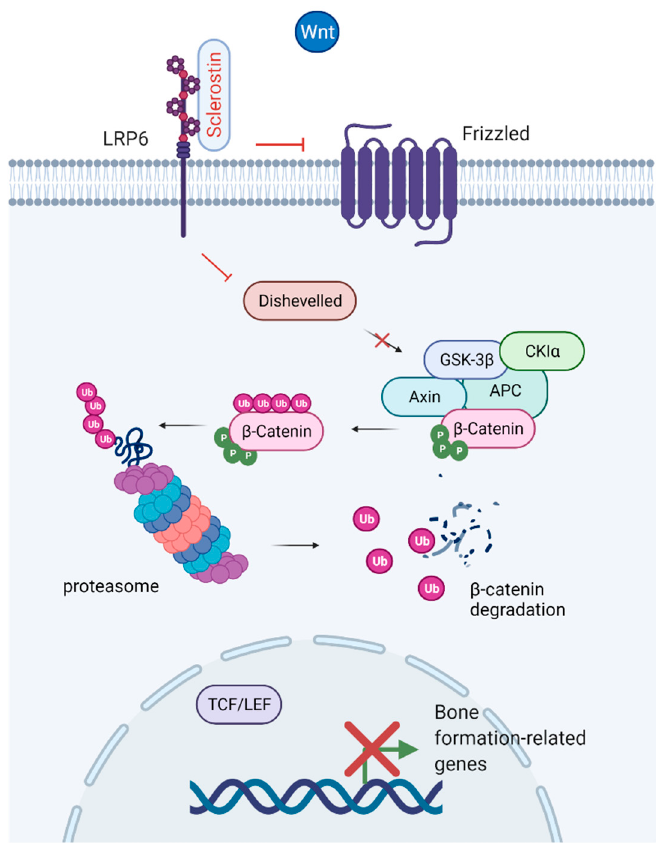
Figure 6. Inhibition of the Wnt/ β -catenin canonical pathway. Binding of sclerostin to LRP6 prevents coupling with the Frizzled receptor. Deactivation of the receptor results in phosphorylation of β -catenin by the APC-GSK3 β complex, translocation of β -catenin to the proteasome and degradation. The enhanced degradation of β -catenin prevents nuclear translocation and binding to the T-cell factor/lymphoid enhancer factor (TCF/LEF) transcription factor complex, which leads to reduced expression of genes related to bone formation. Created with BioRender.com, accessed on 15 February